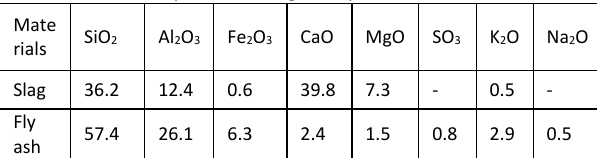
Table 1. Oxide composition of slag and fly ash